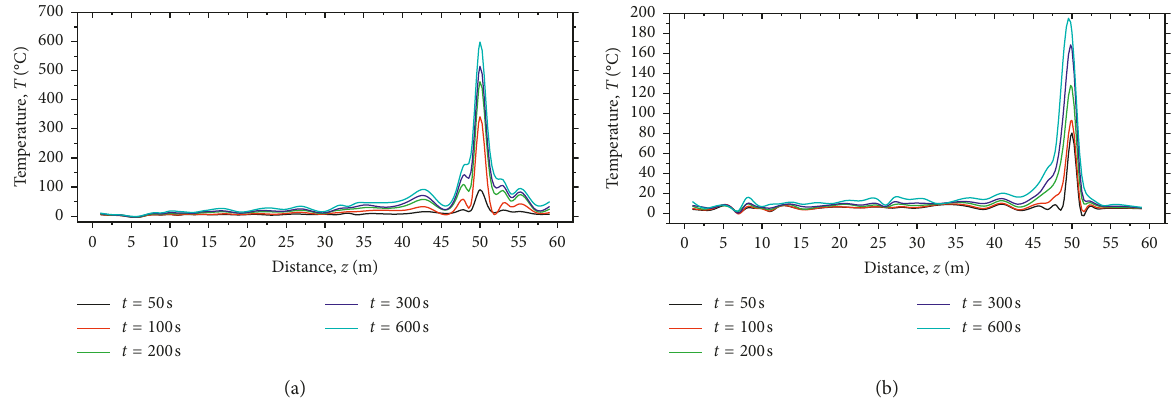
Figure 6: Temperature variation of the main tunnel (Test 9): (a) C1 and (b) P1.